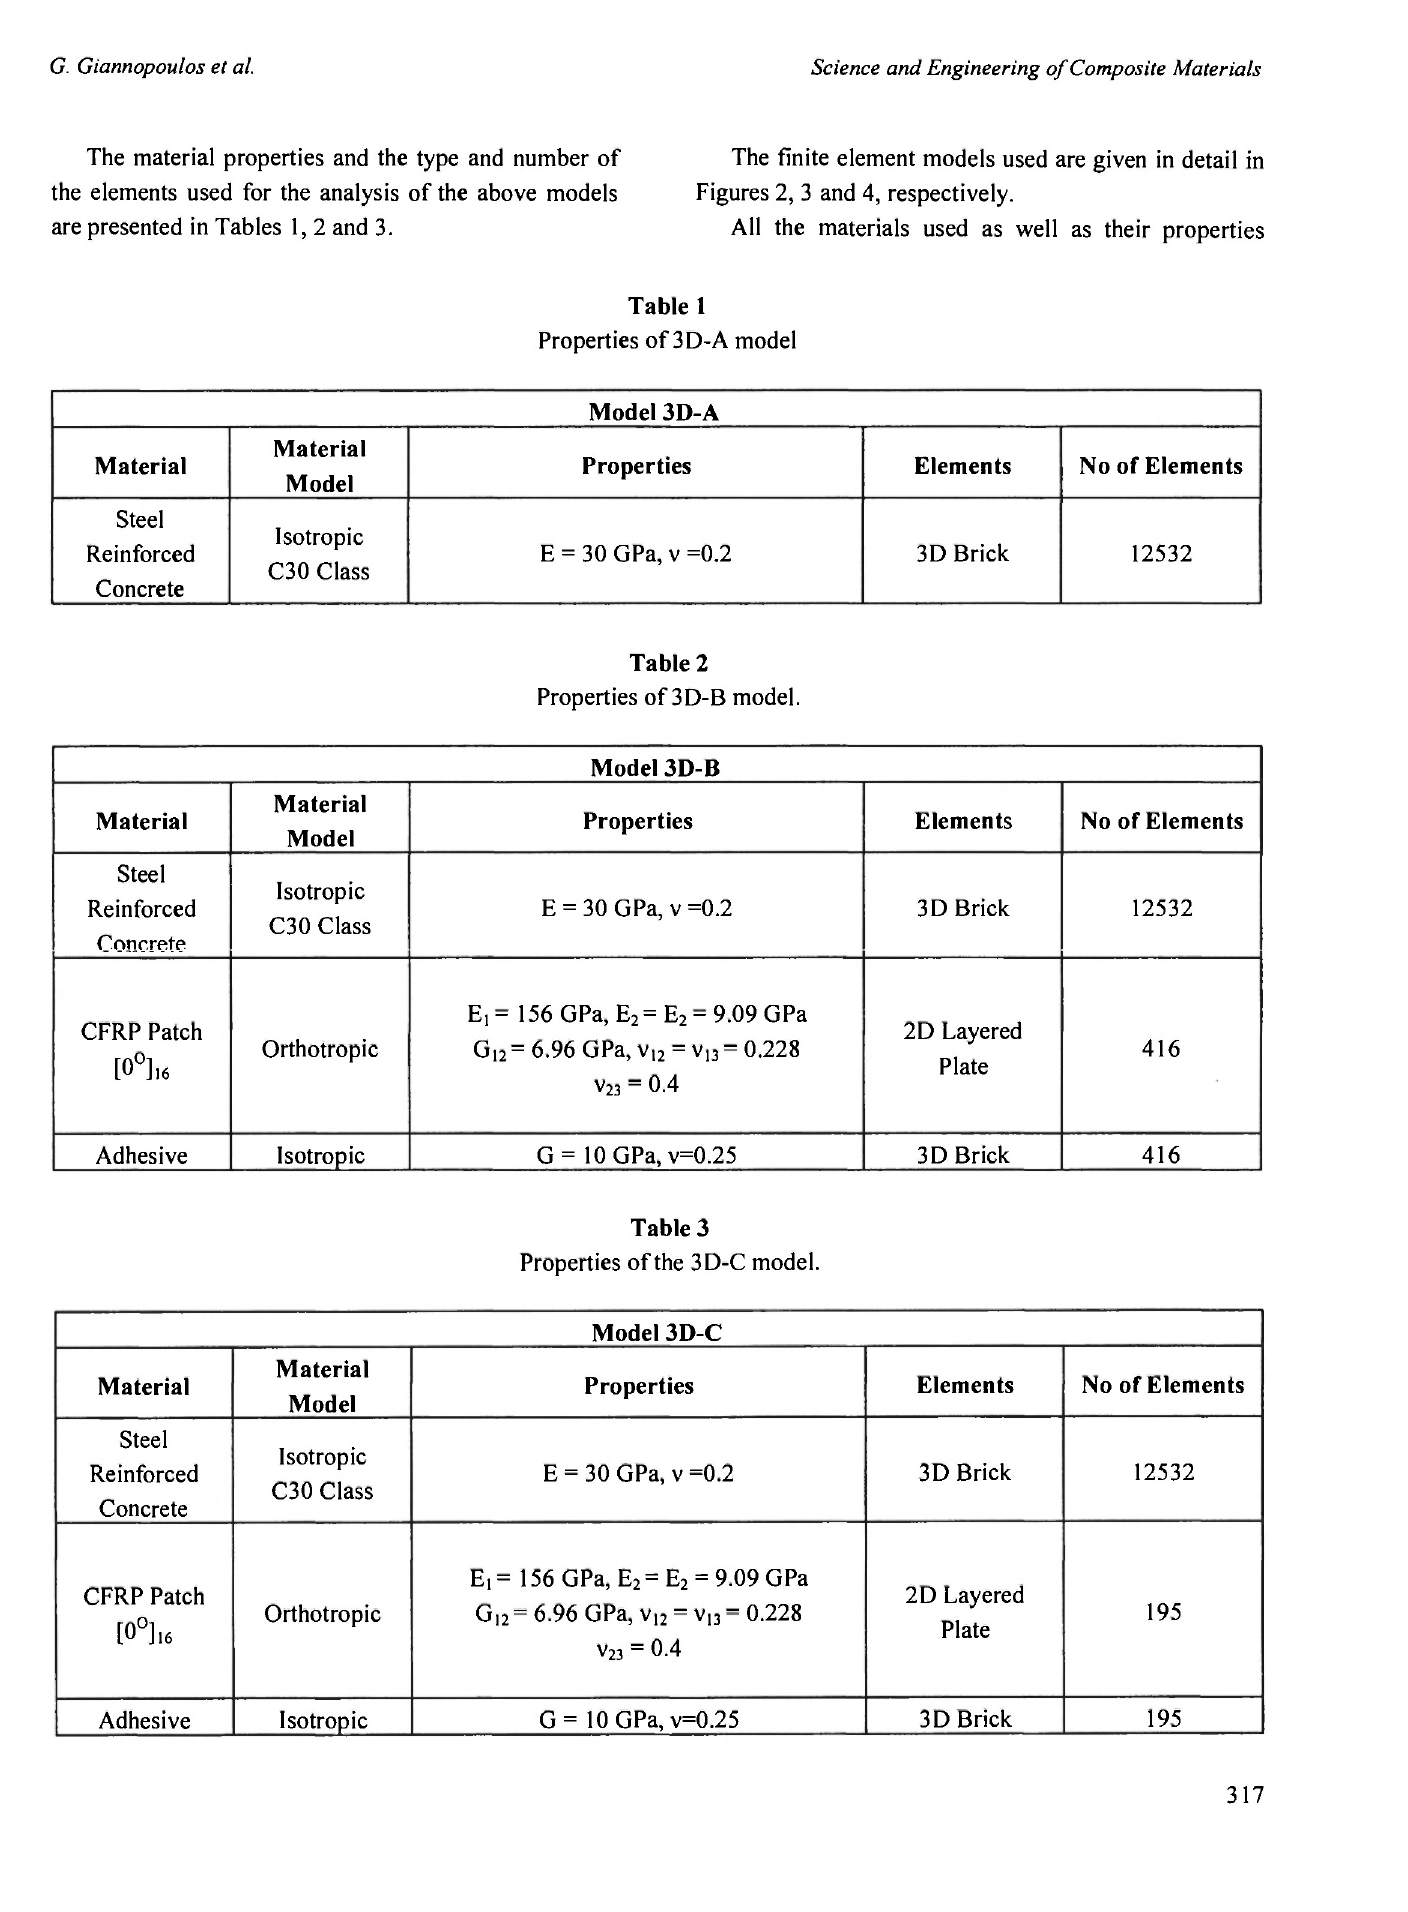
Properties of 3D-B